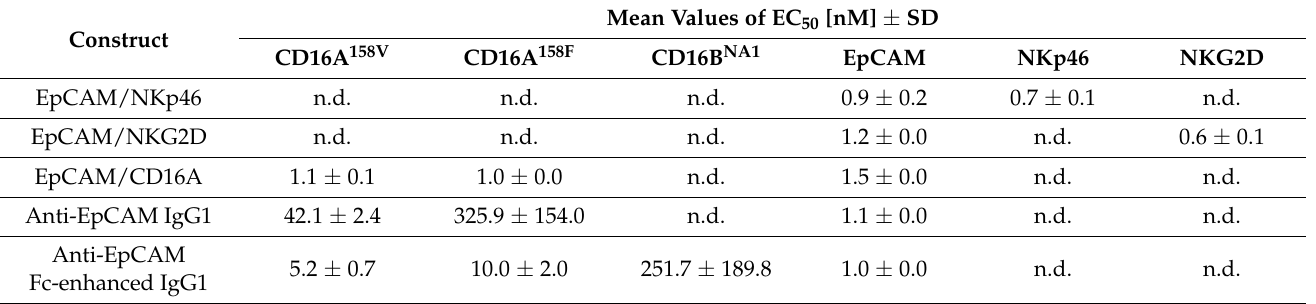
EC 50 are the mean values of two or three independent ELISA experiments ± standard deviation (SD). EC 50 , half-maximal binding constants; ELISA, enzyme-linked immunosorbent assay; n.d., not